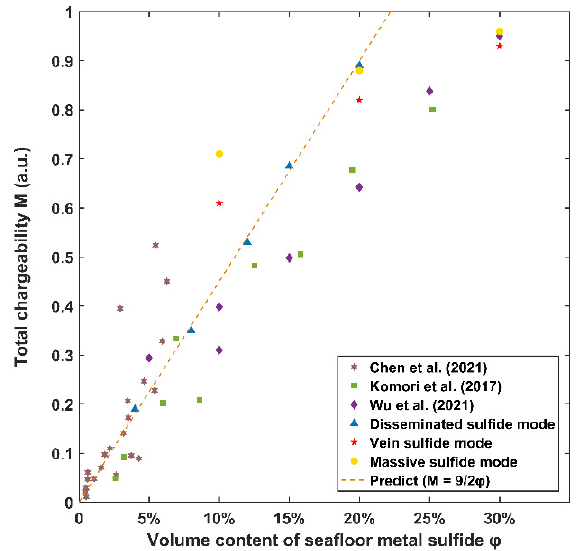
Figure 4. The relationship between chargeability and volume content in seafloor metal sulfides. The simulation data (vein sulfide models, massive sulfide models, and disseminated sulfide models) are from the present study. The experimental data for natural seafloor sulfide rocks are from Chen et al. (2021) [37] and Komori et al. (2017) [10]. The type of sulfides used in Chen et al. (2021) was disseminated and the Komori study included disseminated and massive sulfides. The experimental data for synthetic seafloor sulfide rocks are from Wu et al. (2021) [15]. The red line denotes the prediction of the models proposed by Revil et al. (2015) [18]. In this model, the value of total chargeability was equal to 4.5 times the value of the volume content of disseminated metal sulfides.